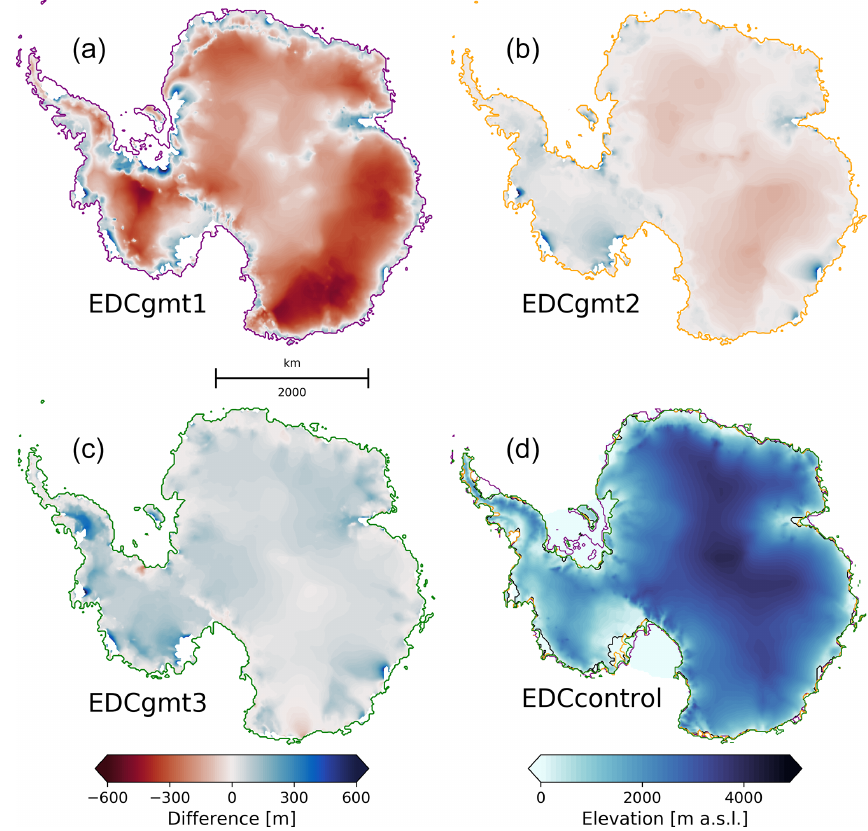
Figure 3. (a–c) Three different starting ice sheet geometries at 420ka for gmt1–3 using EDC forcing. The EDC CFEN member is used as control. The same spatial pattern is seen for DF and Vostok cases, and the averaged ice elevation difference between their respective geometries amounts to less than 50m. The colour scheme shows differences in surface elevation between each geometry and the control for 420ka (d) . Differences are only shown where the ice is grounded in both geometries, and coloured lines show the respective grounding lines in gmt1–3, also overlain in panel (d)